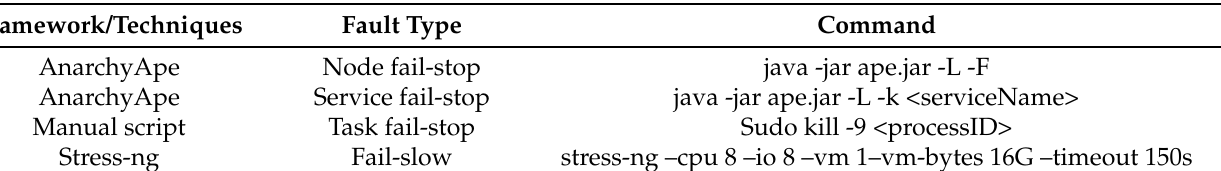
Table 1. Samples of fault options used for fault injection.